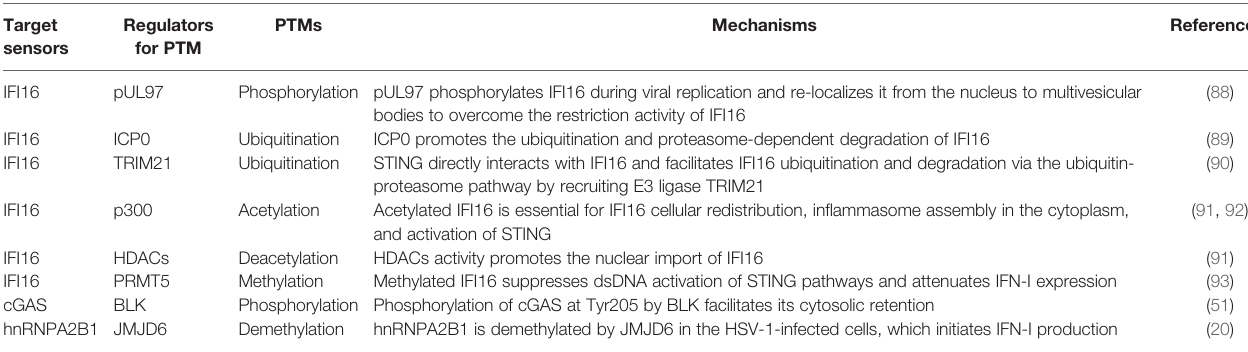
TABLE 1 | PTMs of nuclear DNA